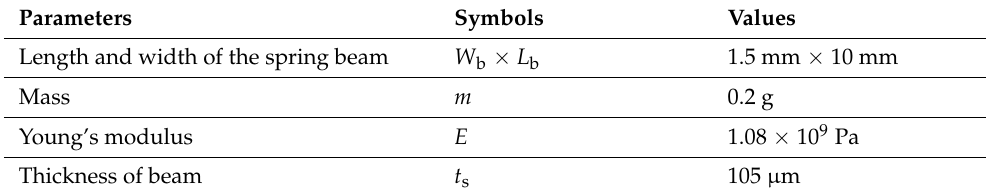
Table 2. Geometric parameters and accelerometer characteristics. Parameters